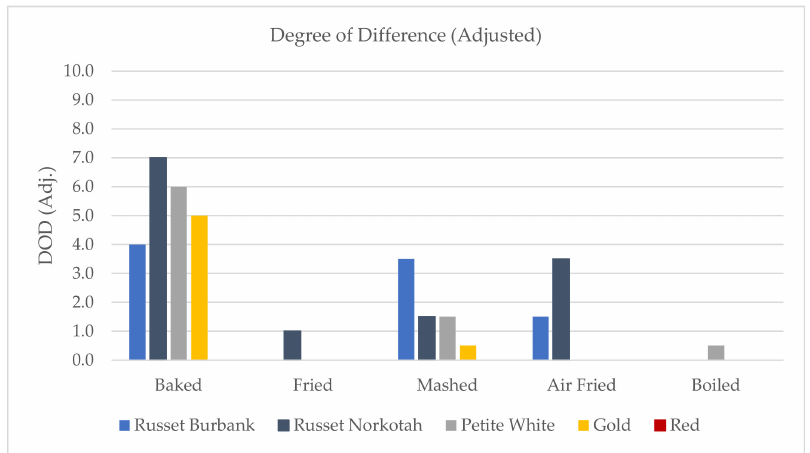
Figure 8. Adjusted degree of di ff erence (DOD) from control scores for all varieties and cooking methods. DOD was rated on a 0–15 scale with 0.5